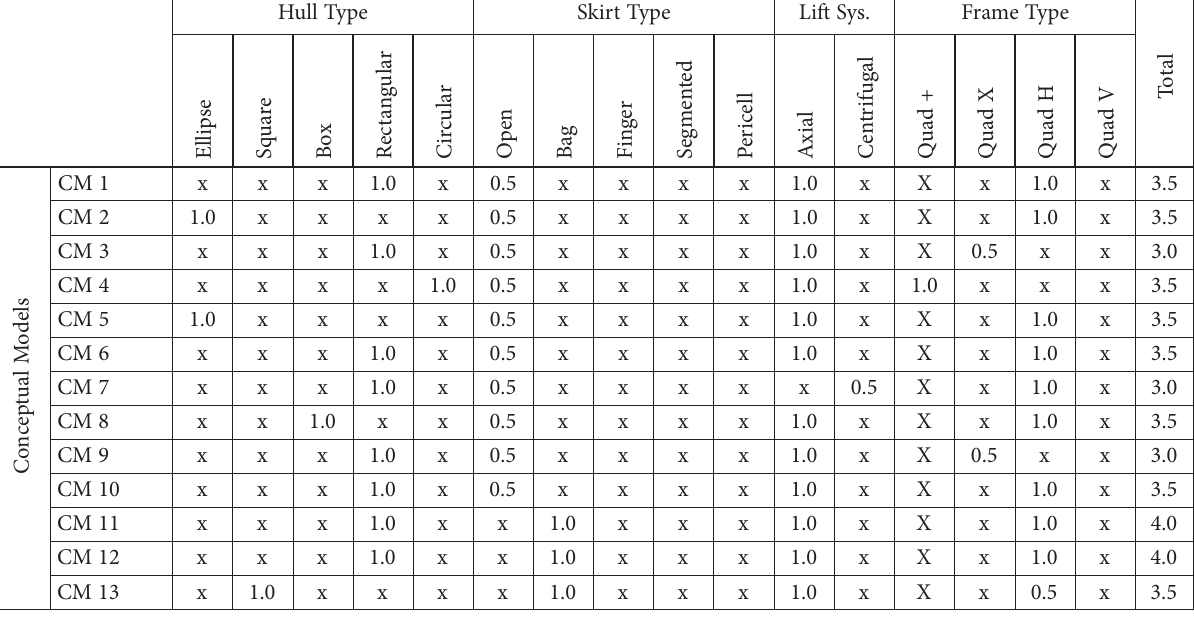
Table A2. Concept generation matrix of